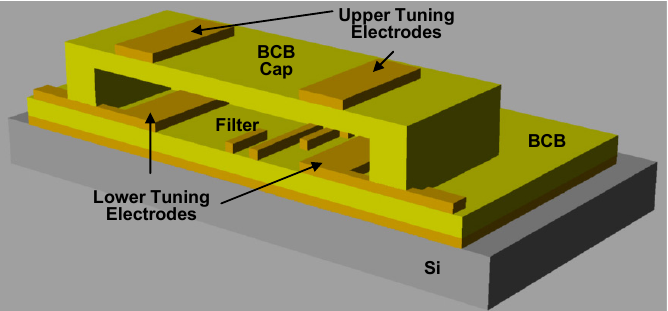
Figure 1. Cross-section of the proposed tunable bandpass